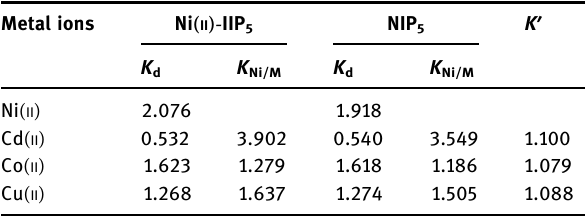
Table 3: Parameters of ion competitive adsorption study for Ni ( II )- IIP 5 and NIP 5